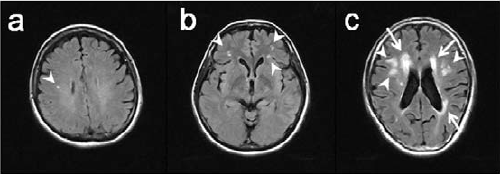
Figure 1. Fluid-attenuated inversion recovery (FLAIR) images of leukoaraiosis. FLAIR images of single subcortical leukoaraiosis (SLA) (a), multiple SLA (b), large multiple SLA (c), and periventricular leukoaraiosis (PLA) (c). Arrow heads and arrows show SLA and PLA, respectively.